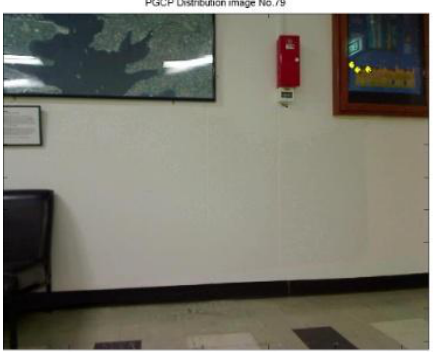
Figure 22. PGCPs on epoch No. 79, which failed to give a position